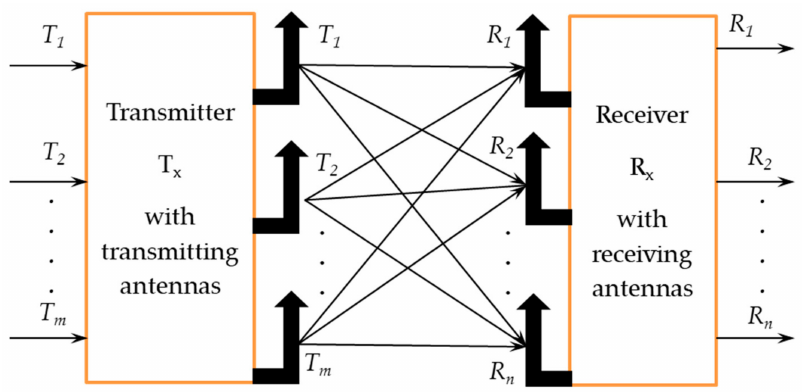
Figure 1. CSI representation of MIMO.